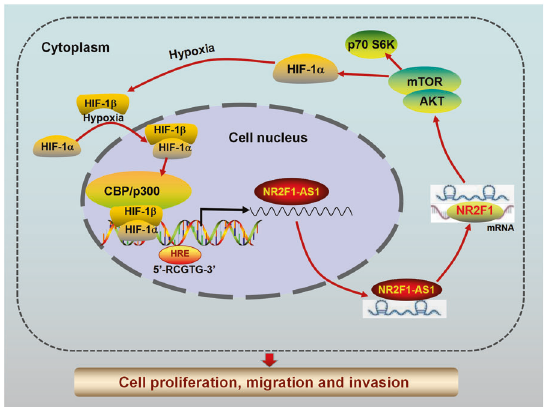
Fig. 9 Schematic illustration of the functions of NR2F1-AS1 in pancreatic cancer. During pancreatic tumorigenesis, NR2F1-AS1 was transcriptionally upregulated by a hypoxia-inducible factor, HIF- 1 α . NR2F1-AS1 promoted PC cell proliferation, migration,